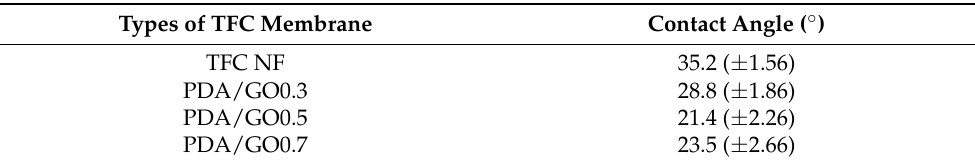
Table 5. Surface contact angle of bottom layer of TFC membrane with and without PDA/GO coating layer.